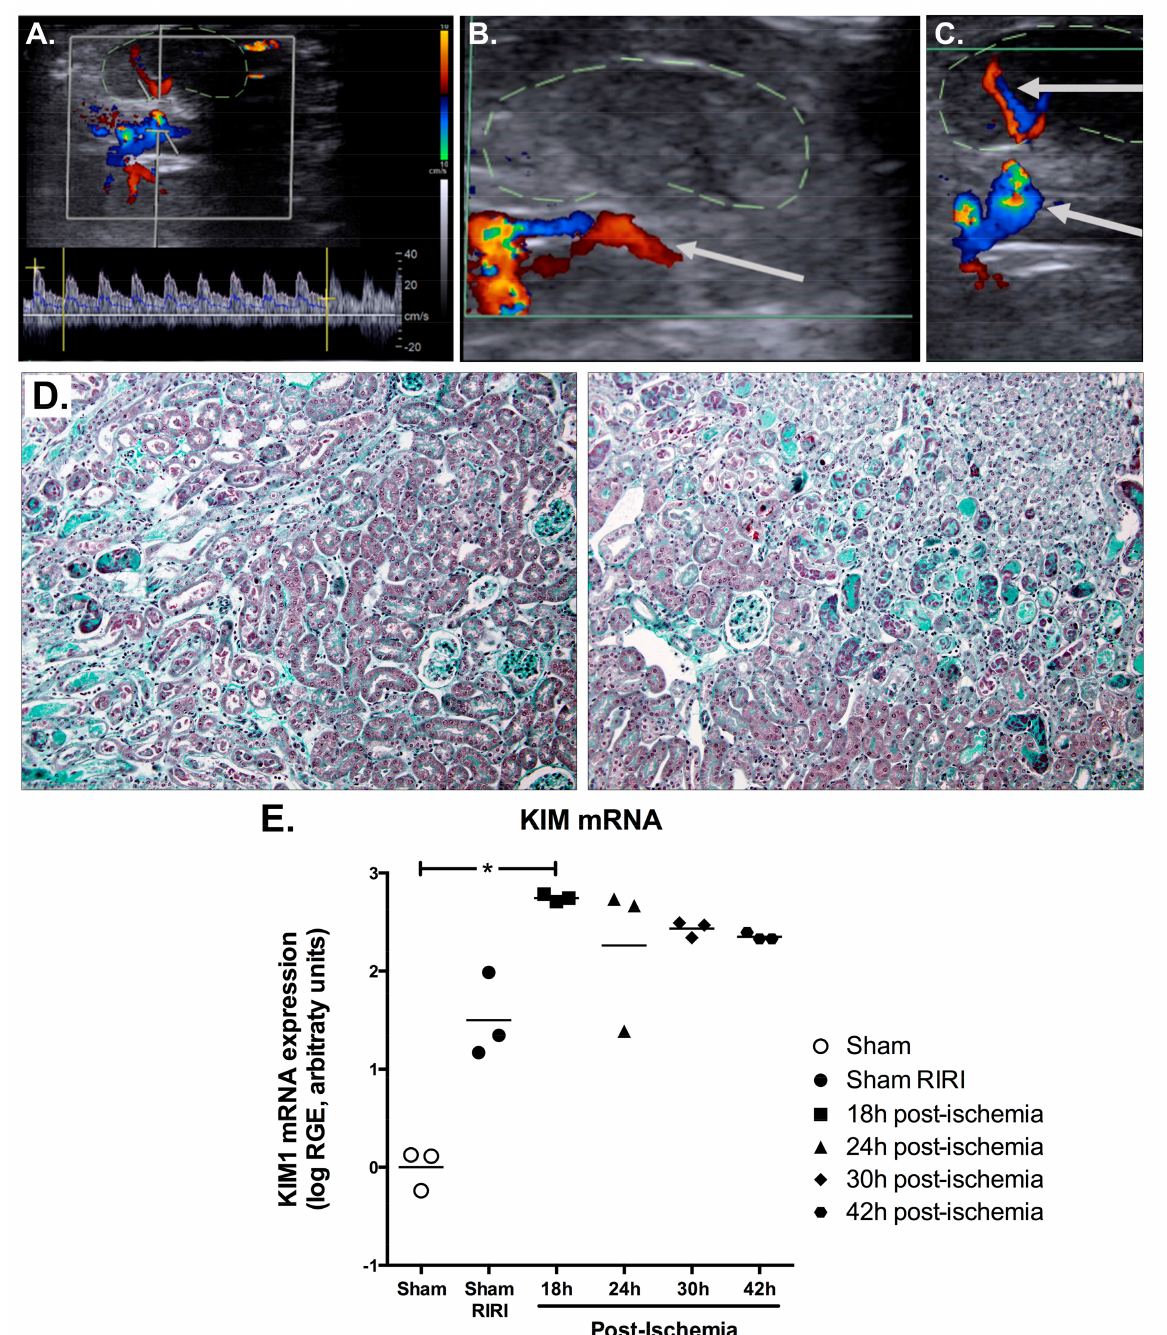
Figure 2. Control of the efficacy of the RIRI clamp. ( A – C ) The renal blood flow was monitored using ultrasound Doppler imaging in slightly anaesthetised mice following a cross-sectional view of the abdomen parallel to the spine, from top to bottom on the image: left kidney, left renal artery, aorta, inferior vena cava and right renal artery. When the clamp was in the open position ( A ), blood flow could be observed in the renal vascular pedicle. This flow was interrupted when the clamp was tightened ( B ) and then re-established when the clamp was released ( C ). ( D ) Representative images of mouse kidneys subjected to a 20-min ischemia followed by 18 h of reperfusion and stained with Masson’s trichrome. A loss of the brush border of the proximal tubules, flattening of the tubular epithelium and intratubular casts at the corticomedullary junction were observed. The tubular damages were confirmed by an increased level of kidney injury molecule 1 (KIM1) transcripts ( E ), which then gradually decreased between 24 and 42 h of reperfusion. The individual log values of KIM1 relative gene expression (RGE) are plotted and the bars correspond to the average ± s.e.m. * p < 0.05 vs. Sham kidneys. (Kruskal–Wallis one-way analysis of variance followed by Dunn’s multiple comparisons